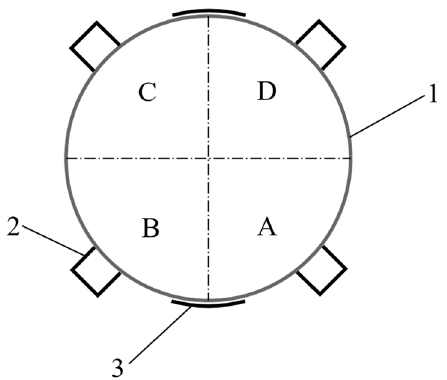
Figure 1. Measurement device position scheme: 1. Cylindrical concrete specimen; 2. LDT devices; 3. Strain-gauge (SG) sensors; A, B, C, and D–sectors.